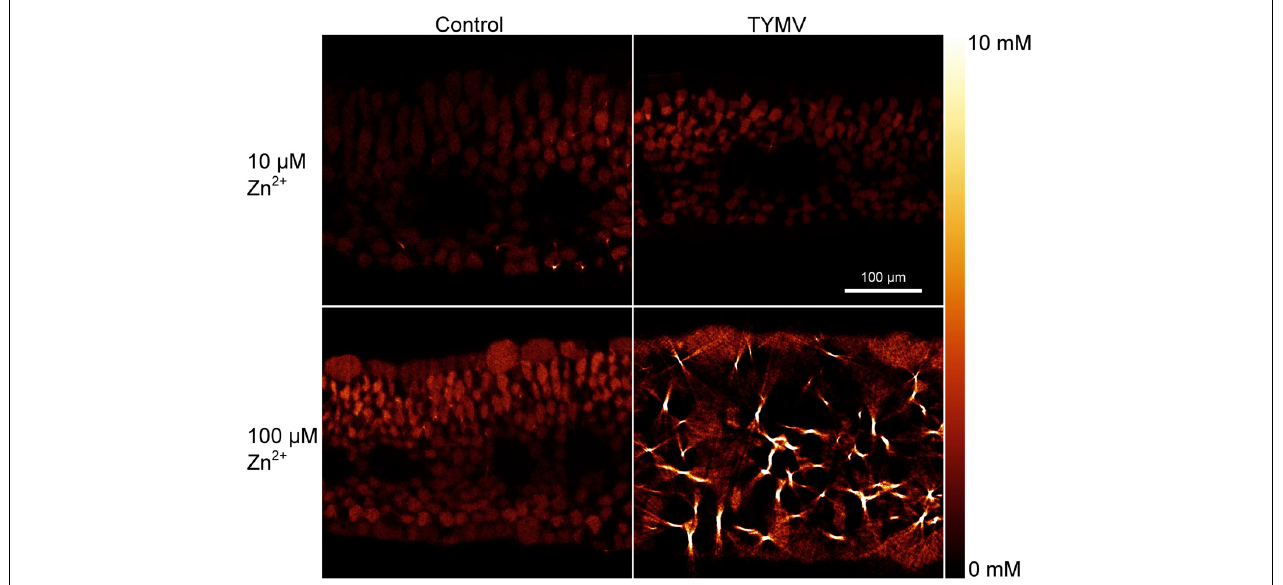
FIGURE 7 | µ XRF tomography of Zn distribution in fully developed N. ochroleucum leaves. The samples were taken at the time of harvest of the plants. At least two replicates from independent experiments were measured for each panel of this figure; representative examples are shown. Top: plants grown with 10 µ M Zn 2 + ; bottom: 100 µ M Zn 2 + ; Left: non-infected plants; right: TYMV-infected plants. The scale bar in the top-right map is valid for all four